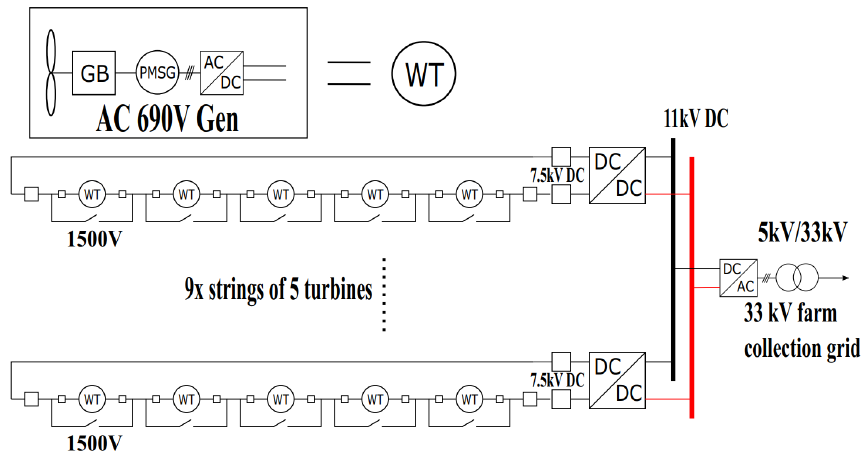
Figure 8. DC series topology.